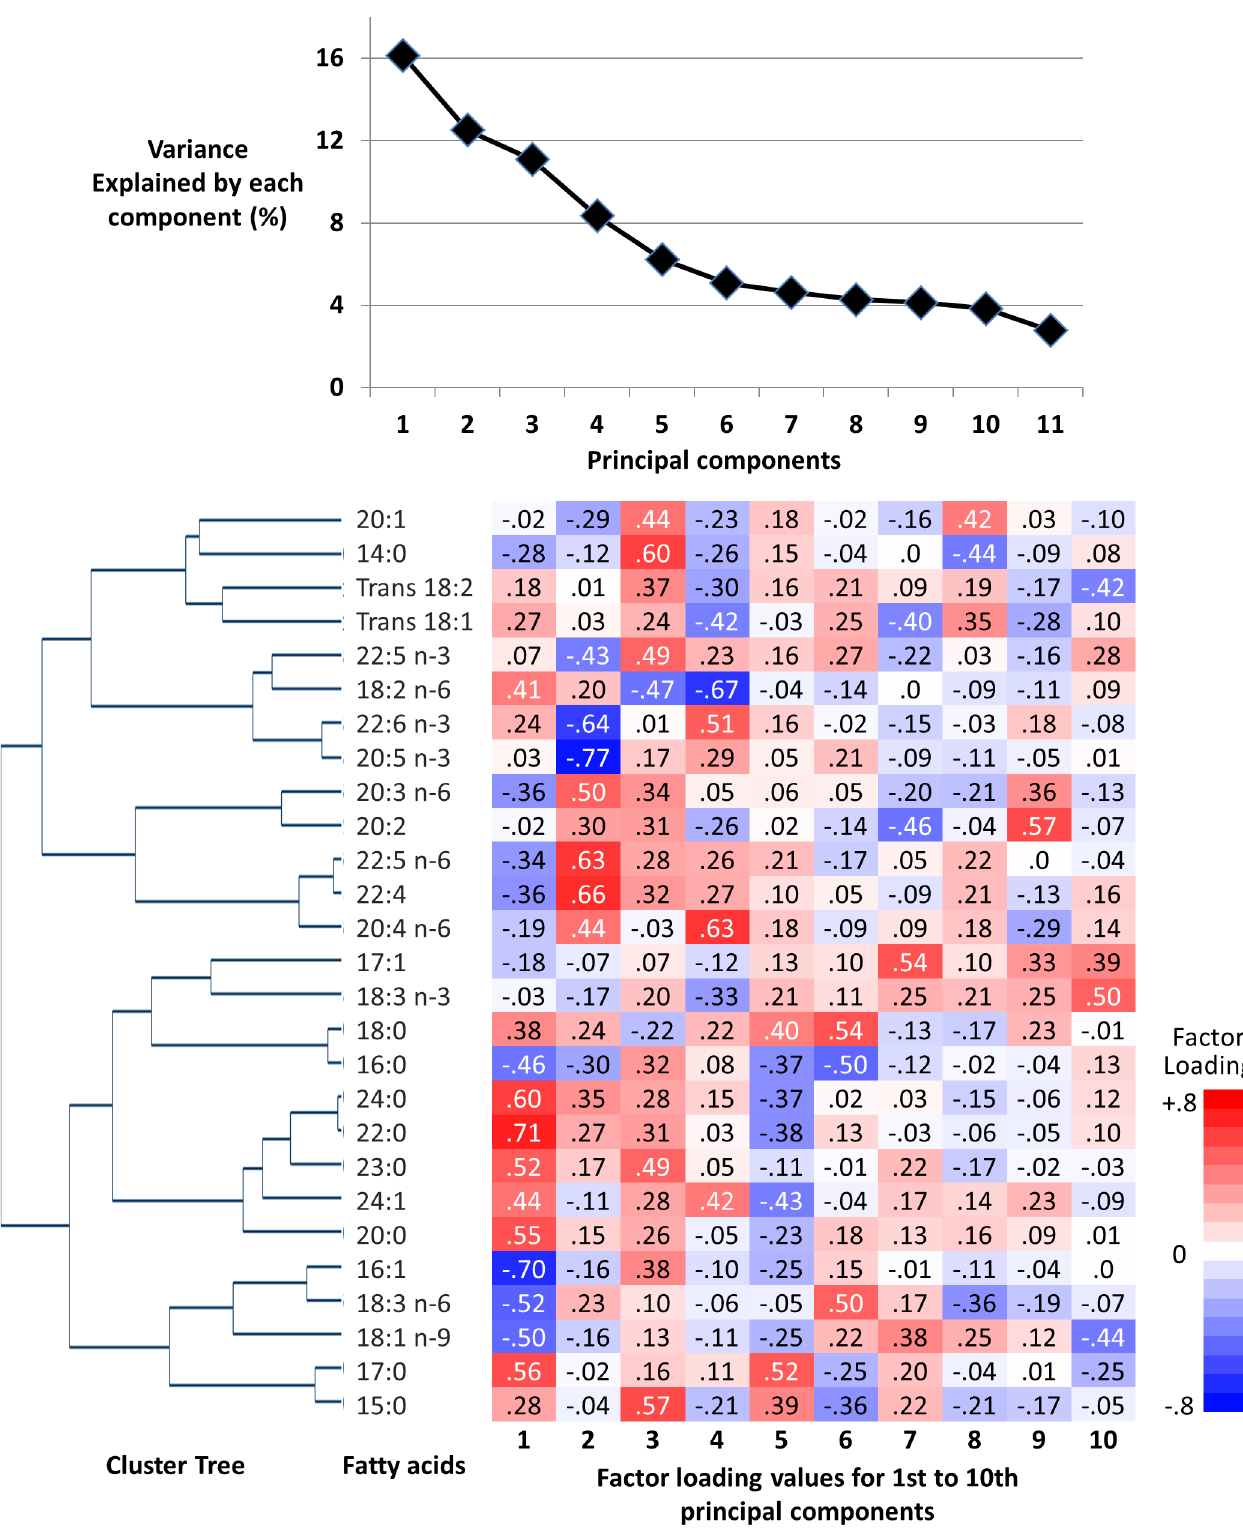
Fig 1. Principal components and clusters of 27 fatty acids in the EPIC-InterAct sub-cohort ( n = 15,919). Top: The proportionof total varianceof 27 fatty acids explained by each principalcomponent.Bottom: Hierarchical cluster tree on the left and factor loadings(measures of contributions of fatty acids to principalcomponents) on the